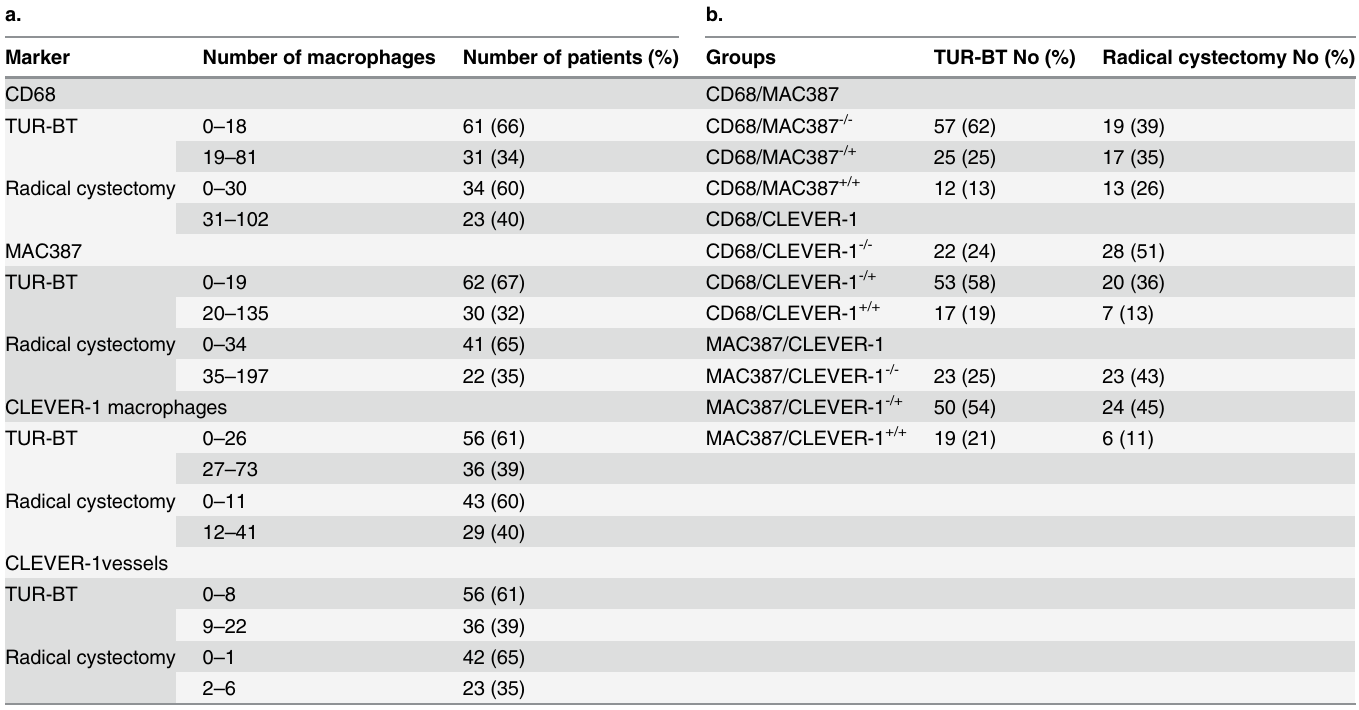
Table 2. Macrophage and lymphatic/blood vessel counts in the TUR-BT and RC cohorts. Data represent the mean number of positive cells from three hotspots (one high-powered field per hotspot). Counts are represented as groups dichotomized according to the mean macrophage count. a, macrophage and vessel counts. b, cell counts according to the expression of two markers. Here, CLEVER-1 staining refers to expression in macrophages, not vessels. a.